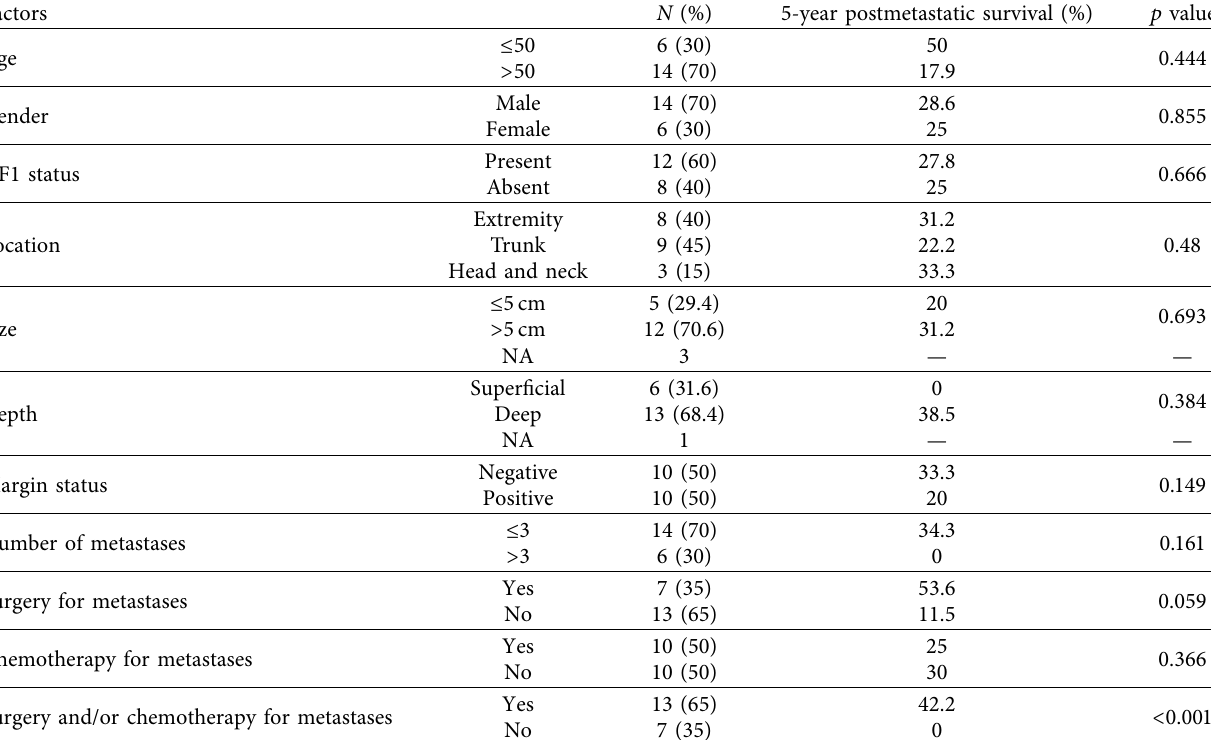
Table 4: Patient-, tumour-, and treatment-related characteristics and univariate analysis of prognostic factors for postmetastatic survival in 20 patients with metastatic MPNST who underwent surgery of the primary tumour.